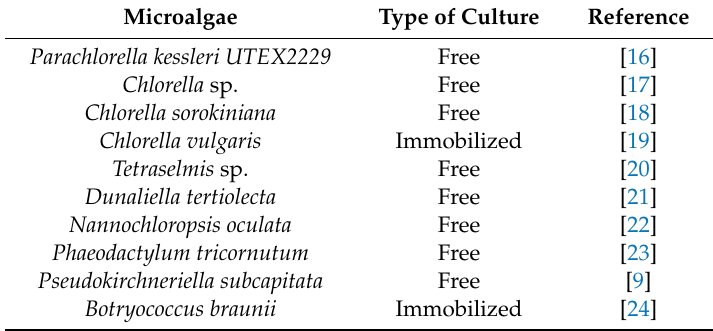
Table 1. Various species of free versus immobilized microalgae used for biodiesel production. Microalgae Type of Culture